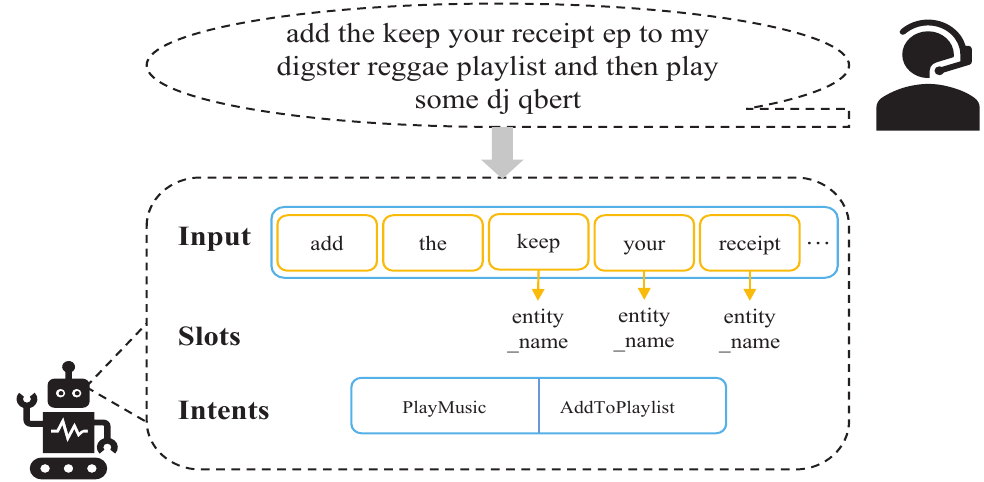
Figure 1. Illustration of a previous example of a joint modeling extracting multi-intent and